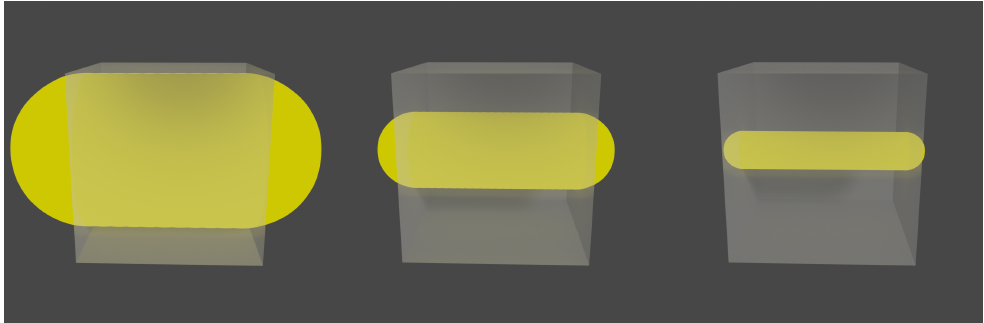
Figure 2. Cylindrical sources moving in a straight line inside a voxel. Sizes are 1, 2, and 4 times smaller than that of the voxel side length (( left ) to ( right